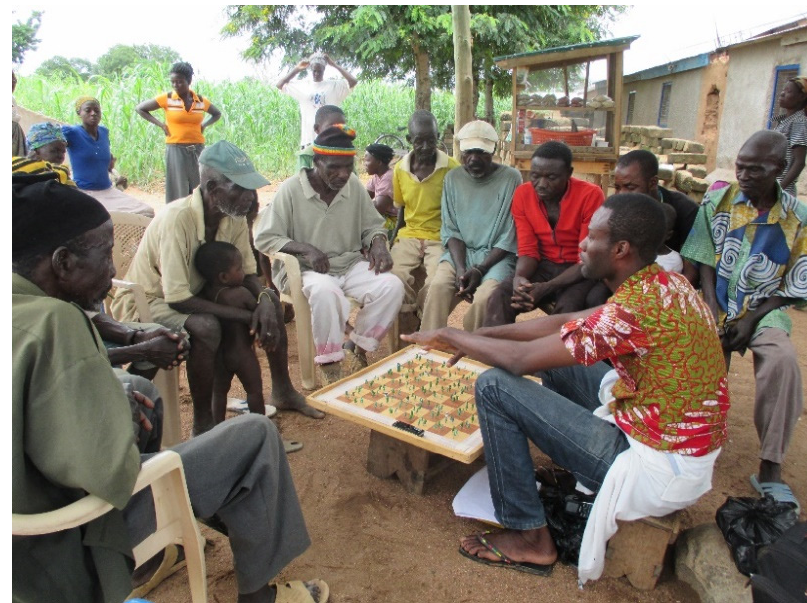
Figure 5. Some selected male players.